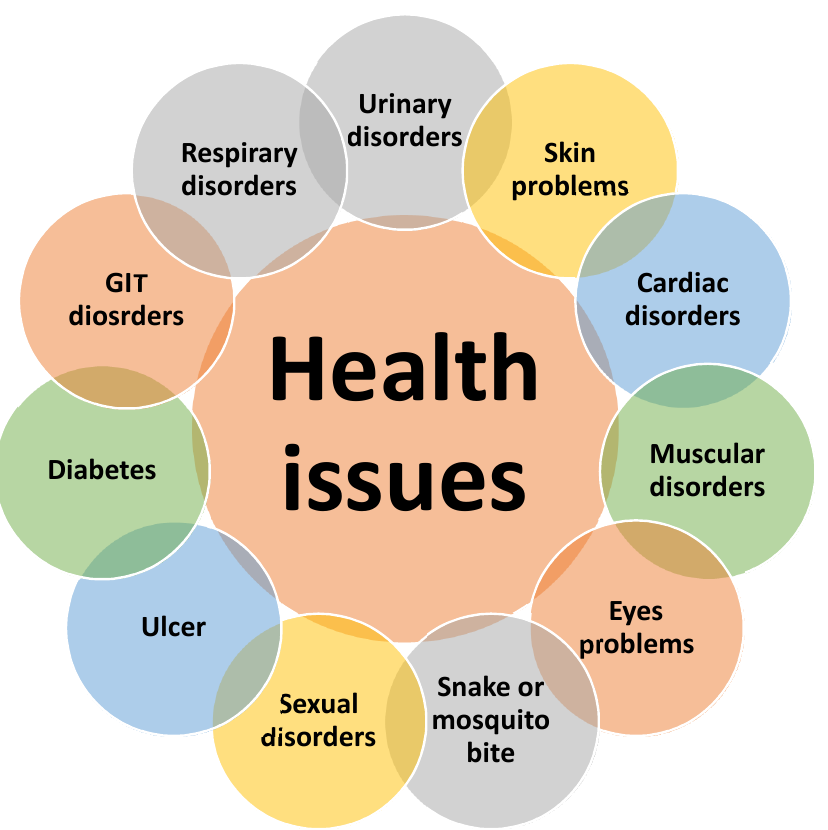
Figure 2. Health issues of the people in the study areas.